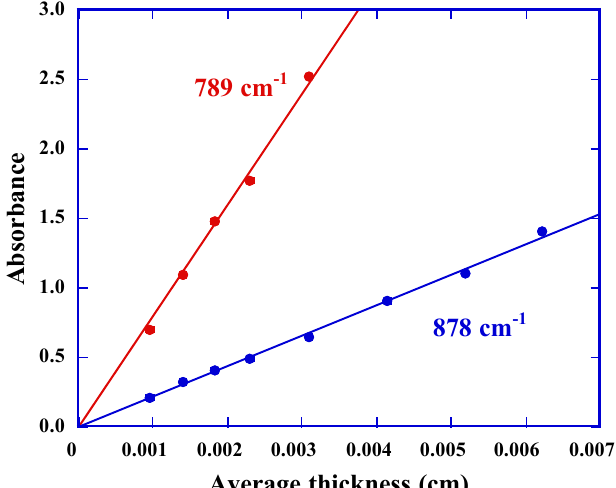
Figure 3. Absorbance of IR peaks of CH groups at indicating wavenumber, as a function of the average film thickness measured by a micrometer [12,15].